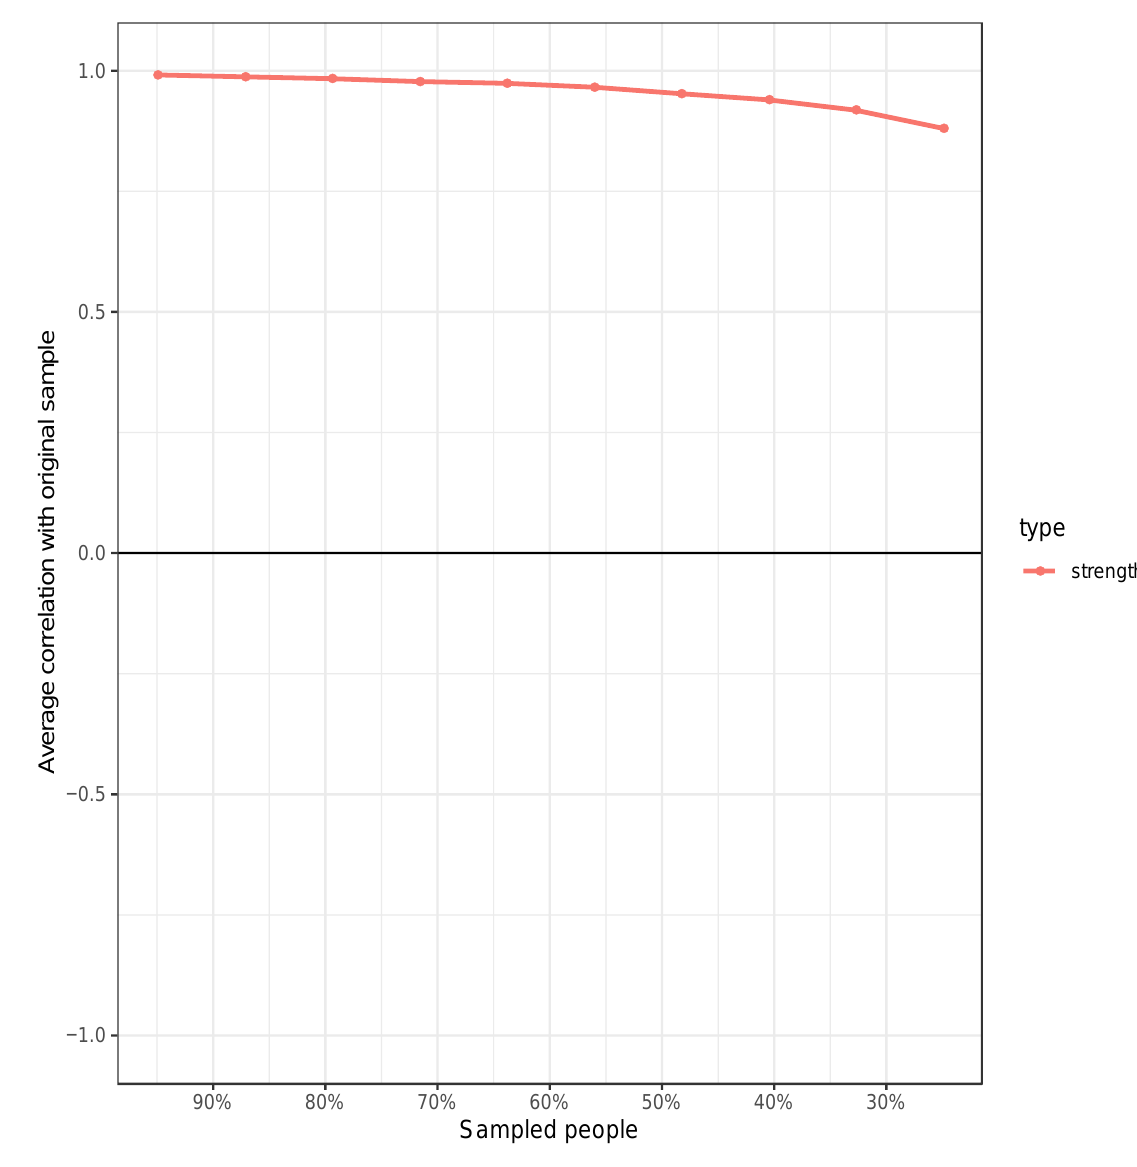
Figure 4. Correlation between the node strength of the PSQ global network and the node strength after randomly dropping a percentage of data from the sample. Note: The stability centrality coefficient (CSC) reports the percentage of cases that can be dropped while still retaining 95% certainty of a correlation of 0.7 between the network centrality estimated on the full sample and the networks estimated on subsamples. Guidance suggests a CSC of 0.5 is desirable; the CSC of the global PSQ network = 0.75.